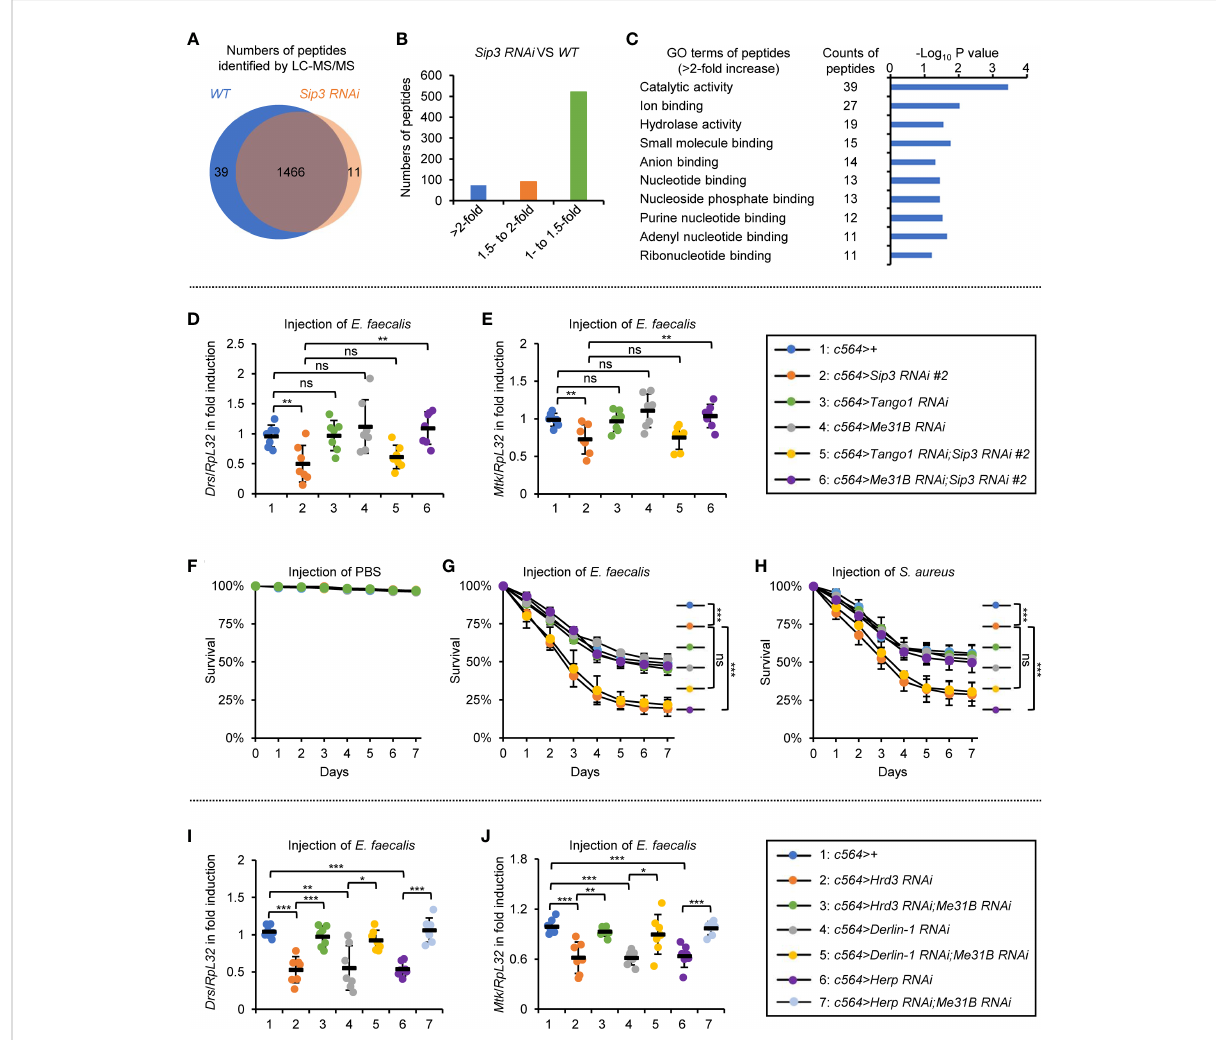
FIGURE 4 ERAD modulates Toll signaling in an Me31B-dependent manner. (A – C) Proteomic analysis of fat bodies dissected from wild-type ( c564 ts ) and Sip3 RNAi ( c564 ts >Sip3 RNAi 2# ) fl ies (100 fl ies for each sample, 3 biological replicate for each group). In (A) , total numbers of peptides/proteins that were identi fi ed by the LC-MS/MS assay. In (B) , numbers of peptides that were increased by various indicated folds (>2-fold, 1.5- to 2-fold, or 1- to 1.5-fold) in the Sip3 RNAi samples relative to the controls. In (C) , gene ontology analysis of the increased (>2-fold) peptides/proteins. (D, E) Flies including 1: c564>+ , 2: c564>Sip3 RNAi #2 , 3: c564>Tango1 RNAi , 4: c564>Me31B RNAi , 5: c564>Tango1 RNAi;Sip3 RNAi #2 , and 6: c564>Me31B RNAi;Sip3 RNAi #2 were infected with E. faecalis . 12 h later, fl ies were subjected to RT-qPCR assays. Each dot represents one independent replicate (10 fl ies for each replicate). (F – H) Flies with same genotypes as in (D) were injected with sterile PBS (F) , E. faecalis (G) , or S. aureus (H) , followed by survival rate assays. The numbers of fl ies were as follows. In (F) , c564>+ :105, 103, 102; c564>Sip3 RNAi #2 : 104, 105, 106; c564>Tango1 RNAi : 105, 106, 105; c564>Me31B RNAi : 102, 103, 105; c564>Tango1 RNAi;Sip3 RNAi #2 : 106, 104, 107; c564>Me31B